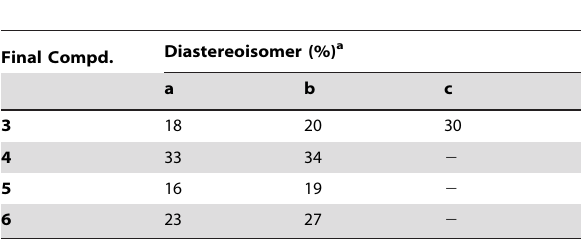
Table 1. Result of the reductive amination of Phe-derived b – ketoester 1 .